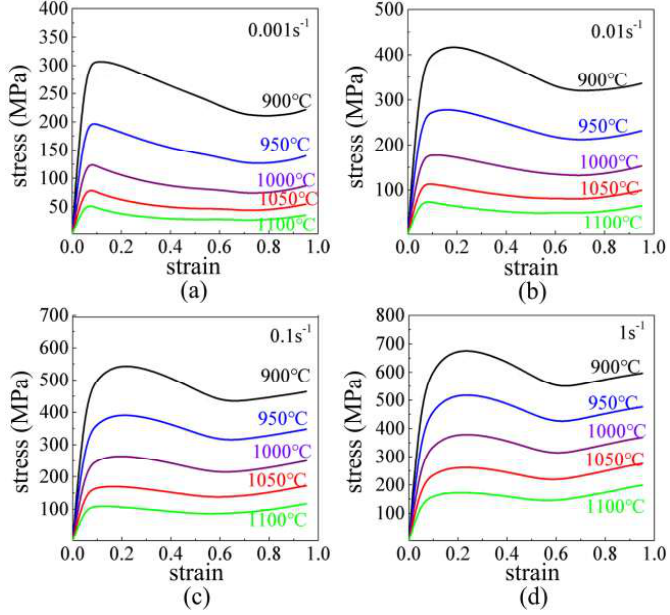
Figure 2. Stress–strain relationship of GH4169 compressed at ( a ) 0.001 s −1 ; ( b ) 0.01 s −1 ; ( c ) 0.1 s −1 ; ( d ) 1 s −1 .